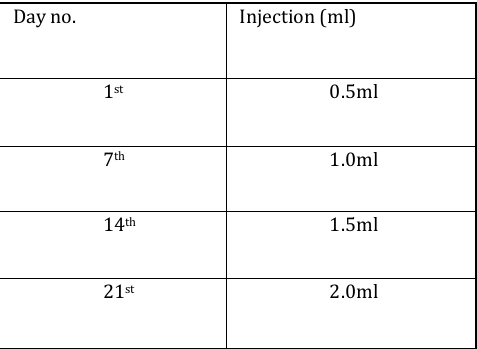
Table 1: Schedule for